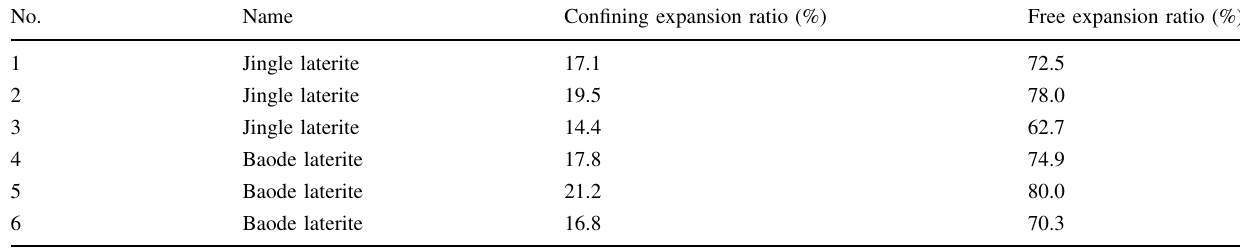
Table 2 Expansive parameters of clay No.